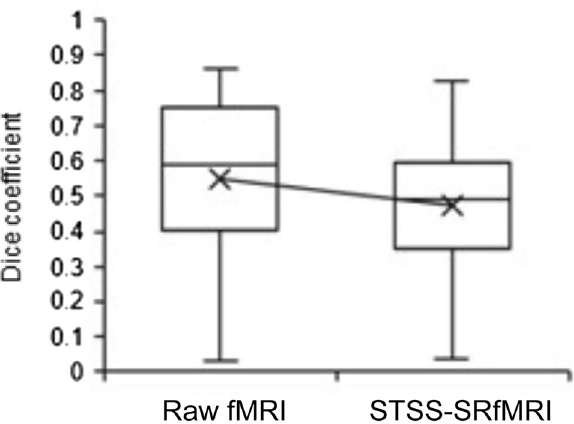
Figure 7. Comparison of the Dice coefficients for the raw fMRI and the Static T2*WI-based Subject-Specific Super Resolution fMRI (STSS-SRfMRI) schemes. The STSS-SRfMRI scheme yielded a significantly smaller Dice coefficient than the raw fMRI (p = 0.00466). The median (interquartile range (IQR)) of raw fMRI and STSS- SRfMRI were 0.590 (0.408–0.735) and 0.490 (0.361–0.589),